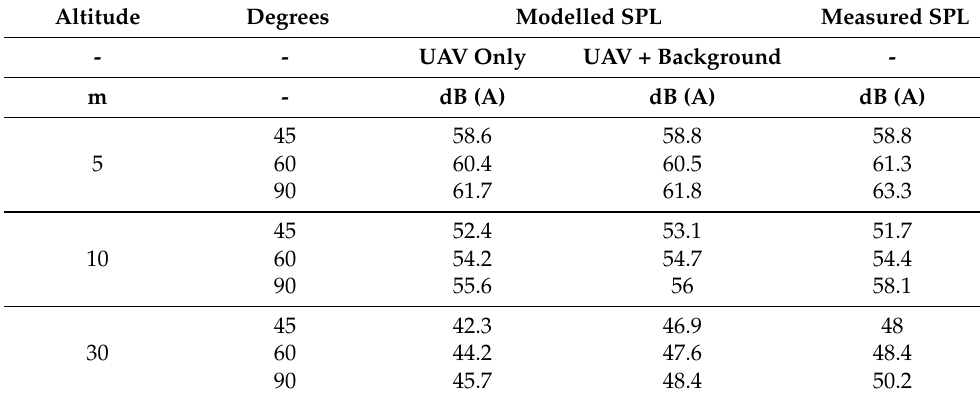
Table 5. Modelled vs. measured sound power levels.